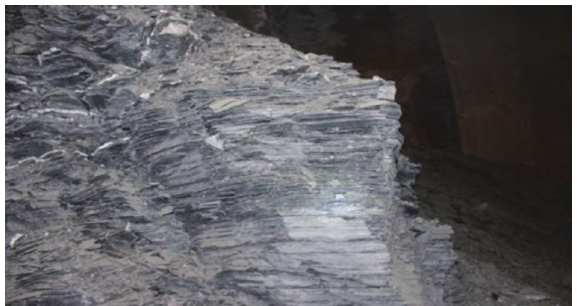
Figure 2: Strata distribution of the left hole.